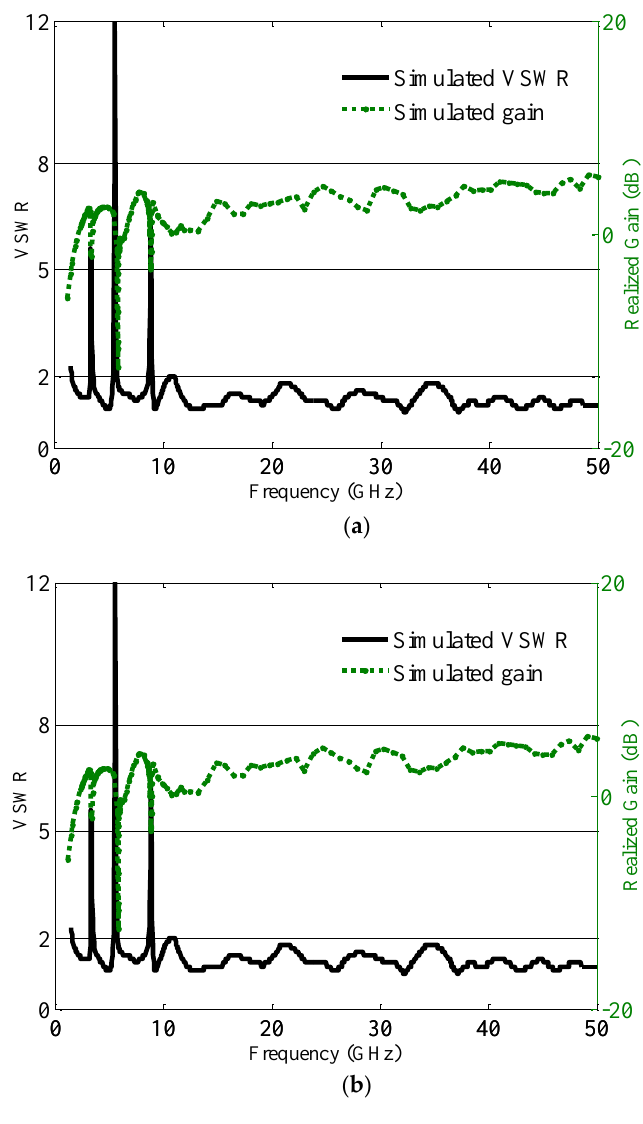
Figure 12. The plot of VSWR versus gain: ( a ) Simulated; ( b ) measured.